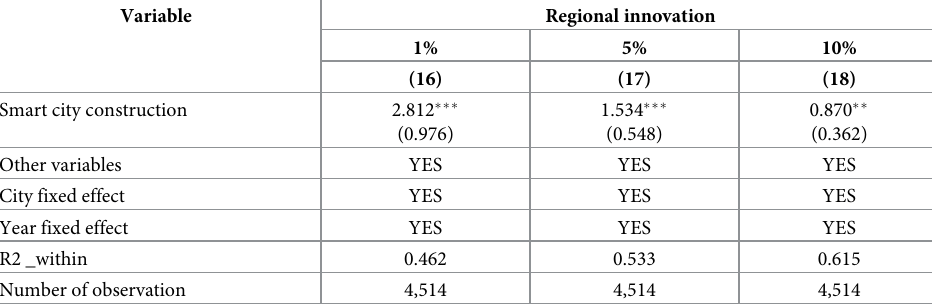
Table 6. Regression results after tail reduction of sample.